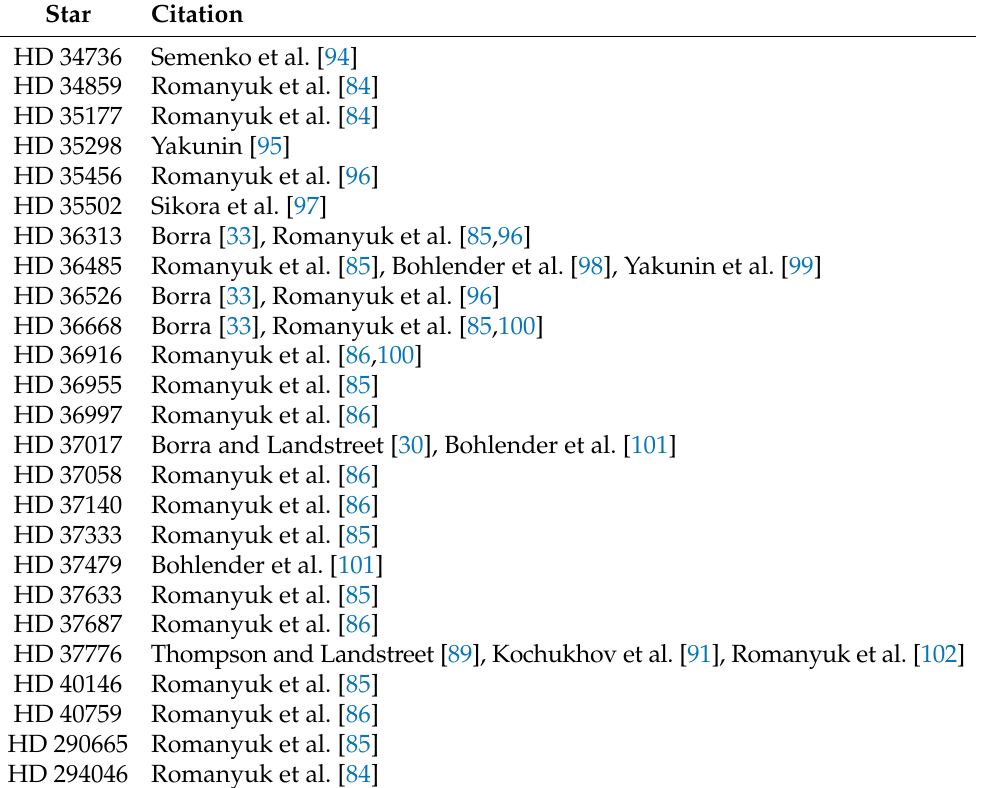
Table 2. List of objects, for which the phase curve of the magnetic field variability is built in the Orion OB1